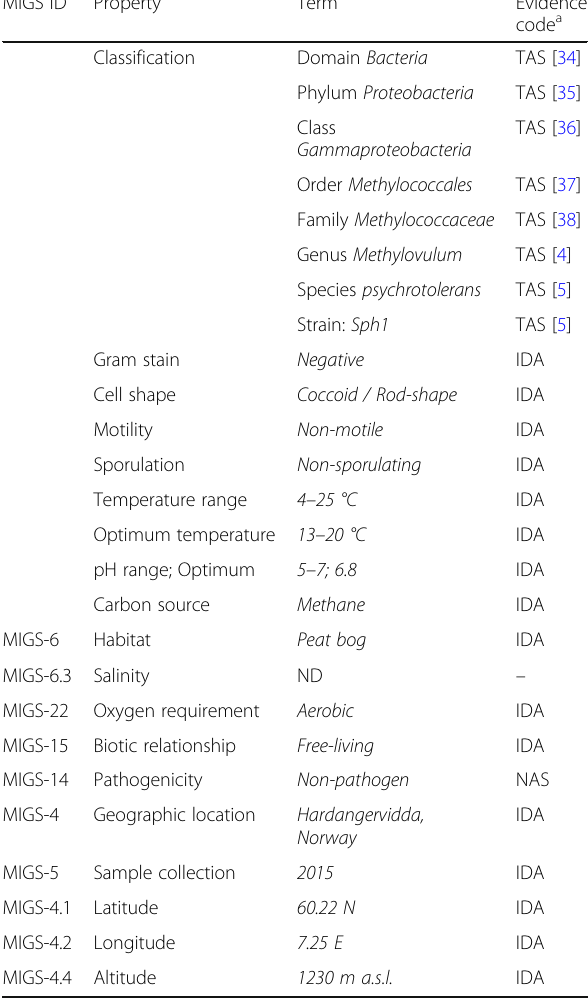
Table 1 Classification and general features of Methylovulum psychrotolerans strain HV10_M2 T MIGS